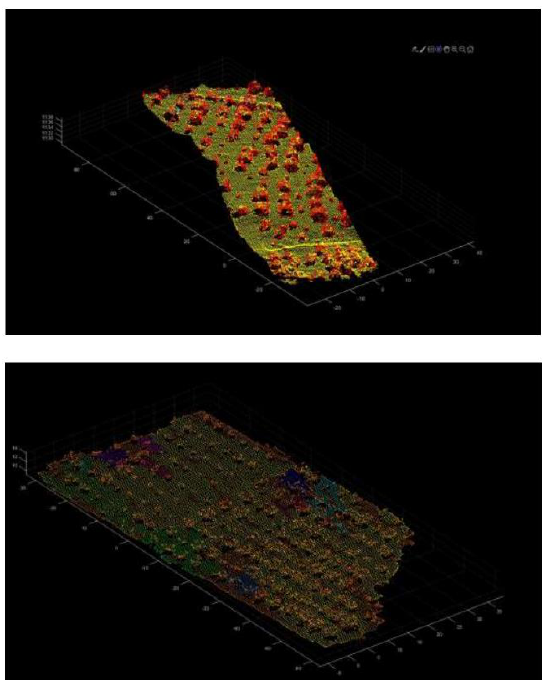
Figure 12. Euclidean-distance algorithm The algorithms were implanted in two different data sets and the outcomes were assessed with the ground truth of trees in the same data sets as the reference map. Validation was done using the kappa coefficient. The outcomes are